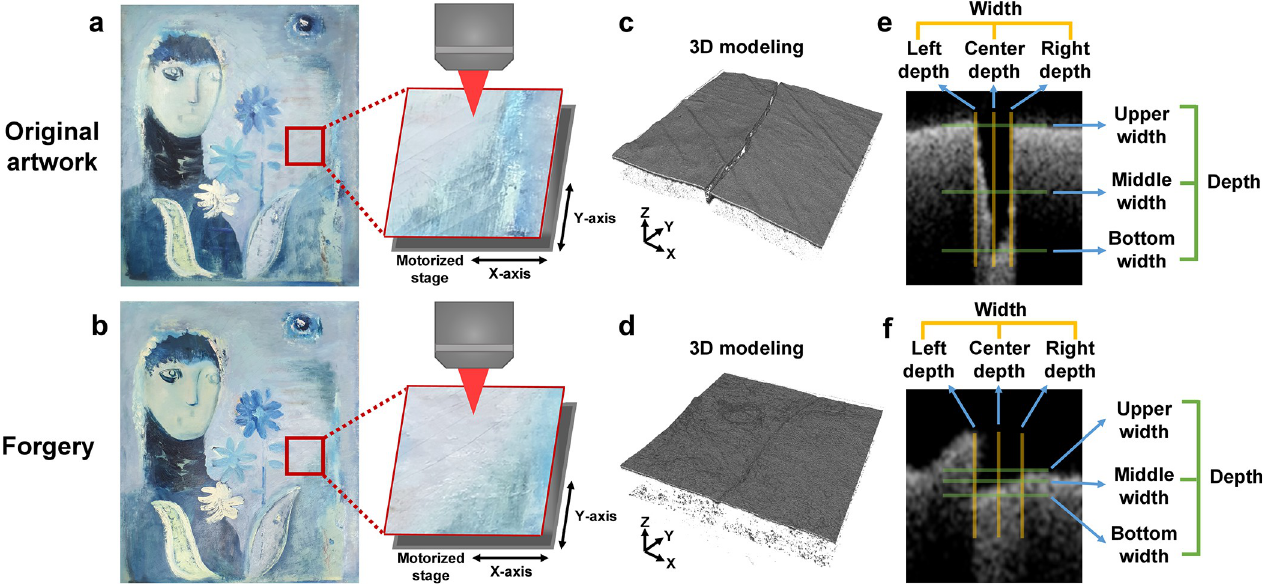
Fig 1. Measurement of the three-dimensional shape of cracks on the surface of artworks through OCT and analysis of the evidence that can be used for authenticity judgment. (a, b) OCT system set-up to measure the crack area of the artwork. This system can fix artworks on the stage to prevent unwanted movement while the artwork is being evaluated. The stage moves them in units of at least 10 μ m along the XY-axis and the focused beam on the crack area to accurately measure the desired area. (c, d) Acquired 3D data of art objects and (e, f) cross-sectional images extracted to compare the width and depth parameters of the original and forged